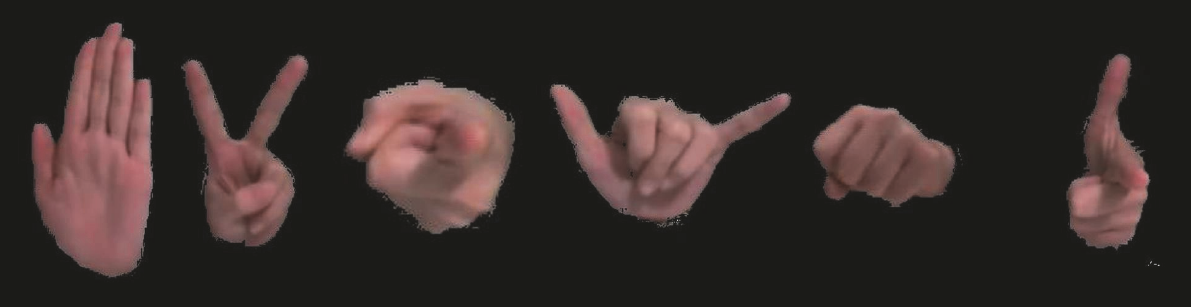
Figure 22: Six classes of posture, from left to right of the postures, are “Palm,” “V,” “Point,” “Y,” “Fist,” and “Eight.”